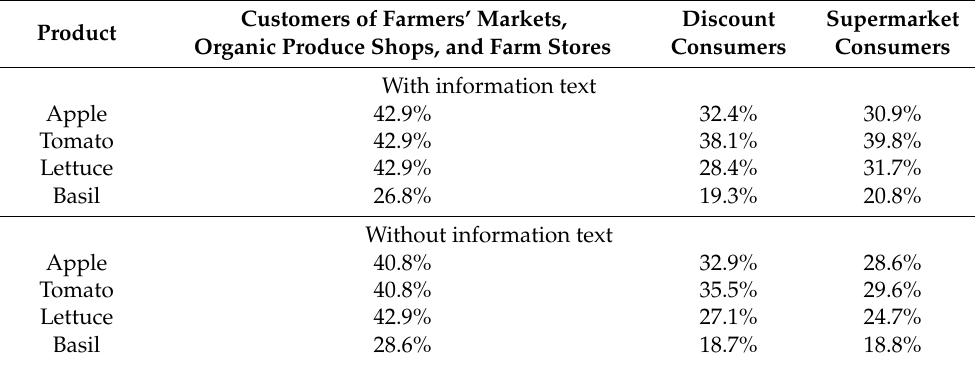
Table A3. Proportion of respondents rating the presented iodine-biofortified fresh products as very appealing as affected by the location of purchase. n = 1016.